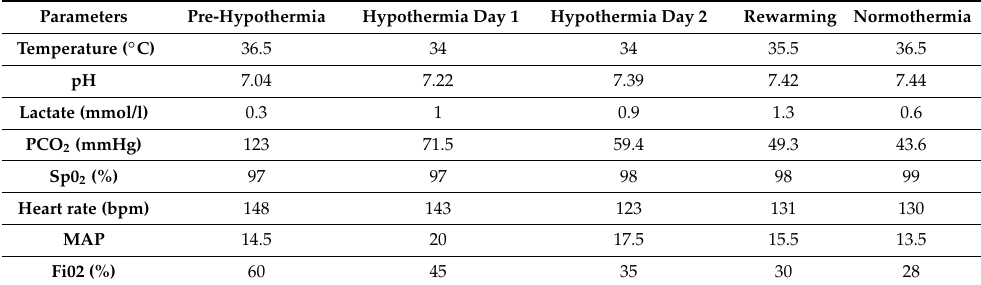
Table 1. Vital signs, blood gas values and ventilatory parameters of the infant before, during and after therapeutic whole-body